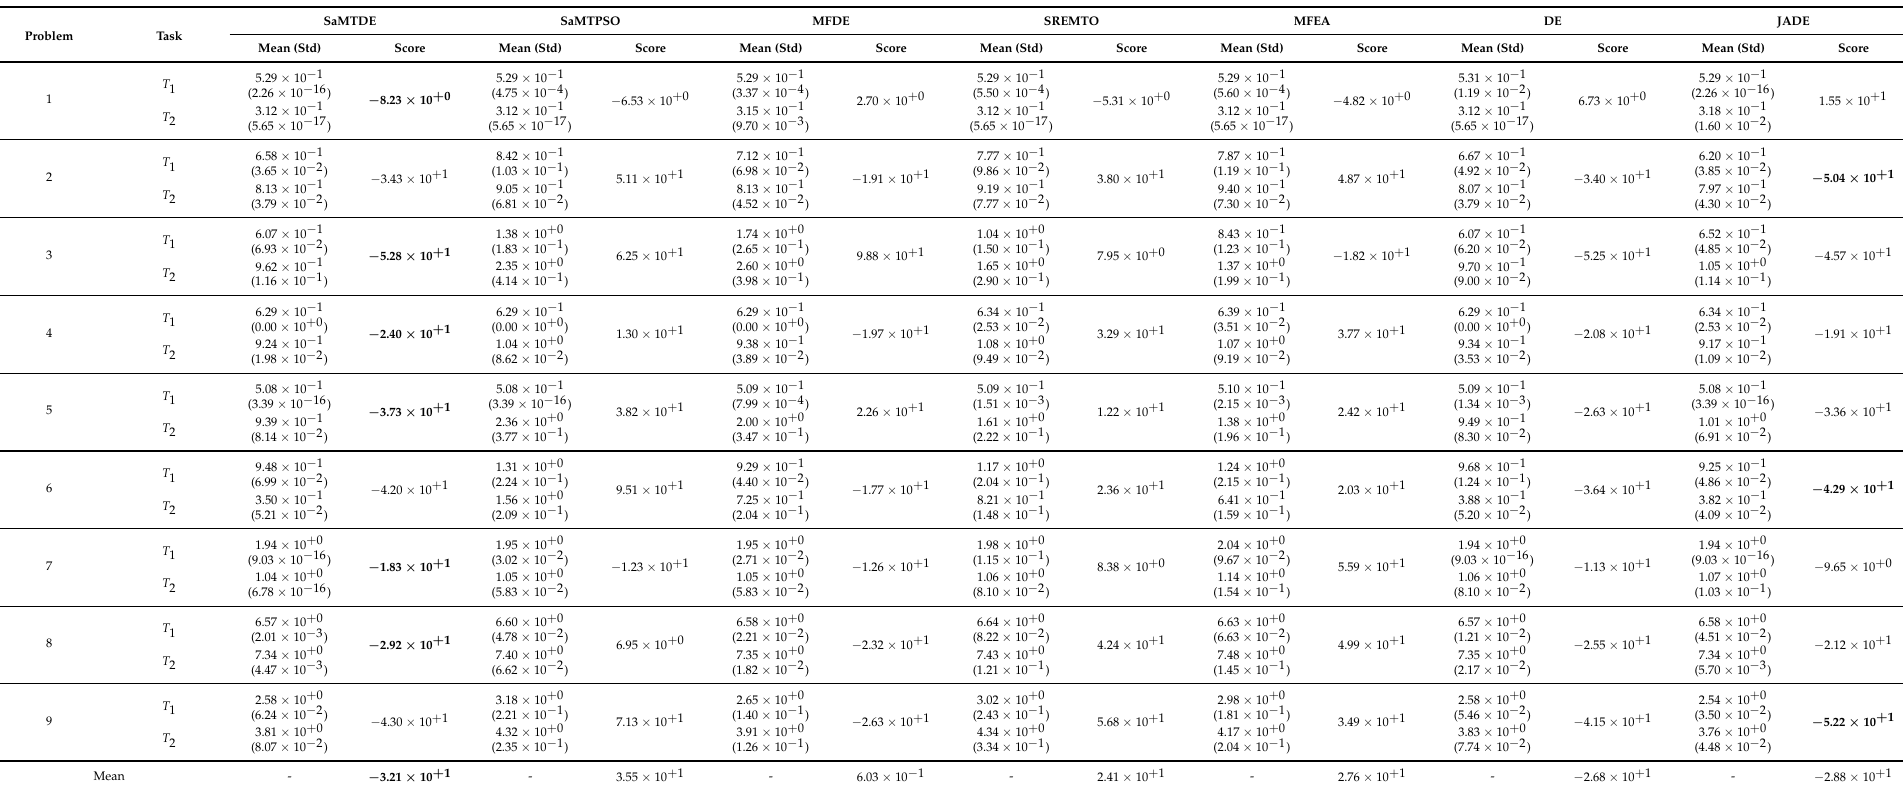
Table 5. Achieved FVs (mean, bracketed standard deviation) of the SaMTDE, the SaMTPSO, the MFDE, the SREMTO, the MFEA, the DE and the JADE. The best results are shown in bold.